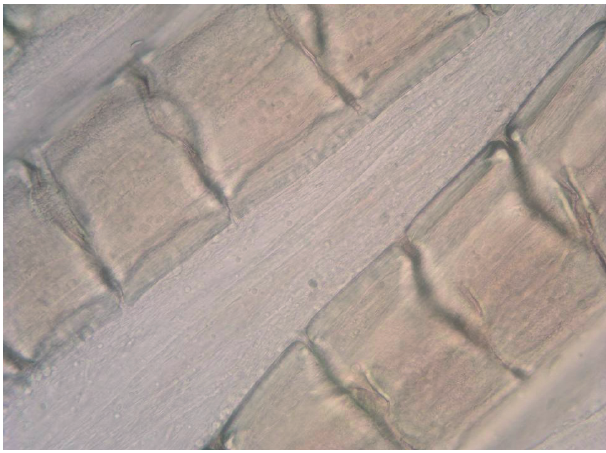
Fig. 3. Detail of the caudal-fin of a pigmented specimen of T. itacarambiensis , not treated with DOPA. Magnification 200x.